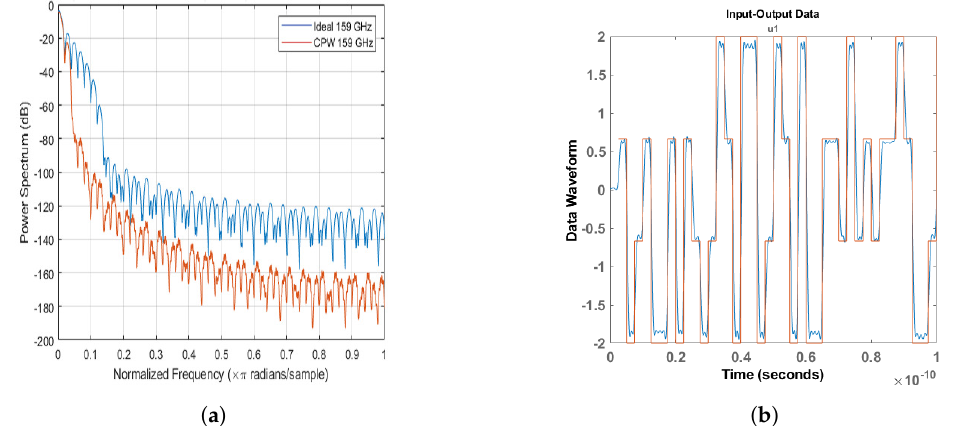
Figure A2. ( a ) Power spectrum of Ideal (blue) and CPW Electrode Filters (orange). ( b ) Input and output